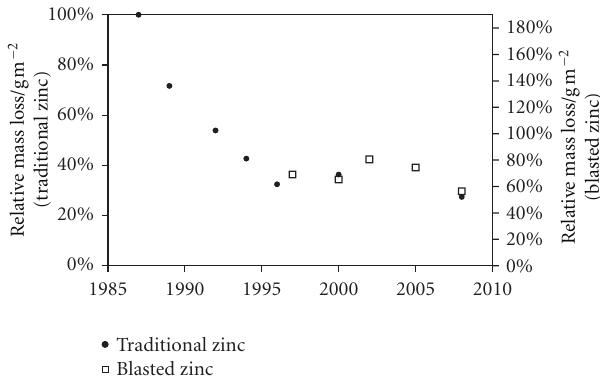
Figure 4: Average relative zinc corrosion at ICP Materials test sites. Values for both traditional and blasted zinc have been normalised to the 1987-1988 value for traditional zinc before averaging.